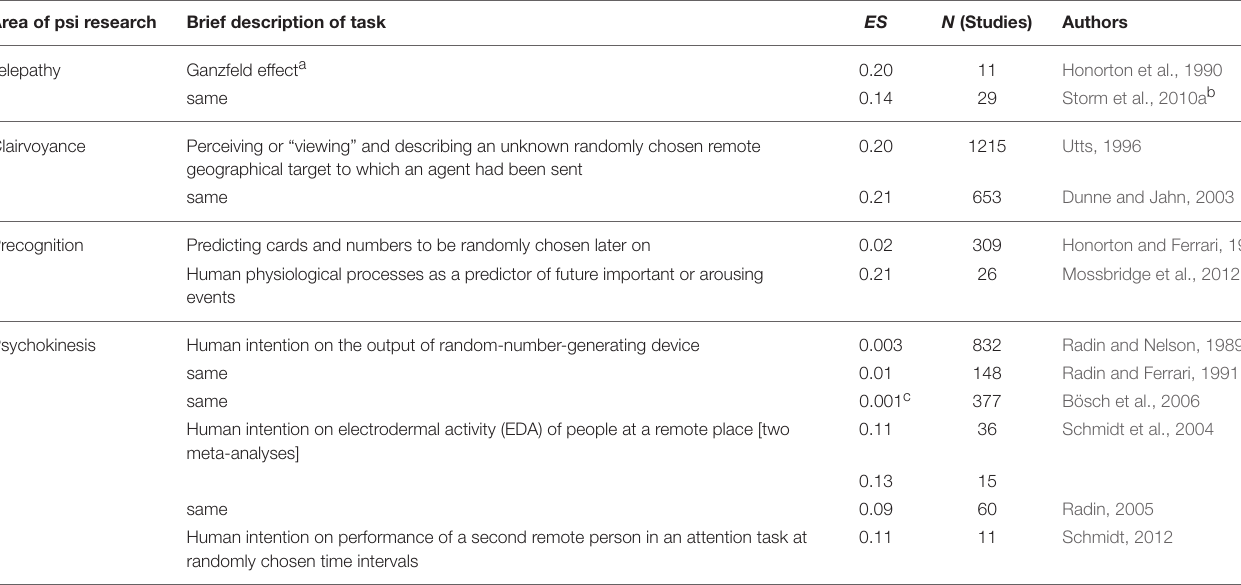
TABLE 1 | Results in meta-analyses on psi phenomena, divided up into four areas of research: telepathy (receiving information from somebody distant in space), clairvoyance (perceiving events at a distance in space), precognition (receiving information about future events), and psychokinesis (influencing physical objects or physical and physiological processes by one’s conscious